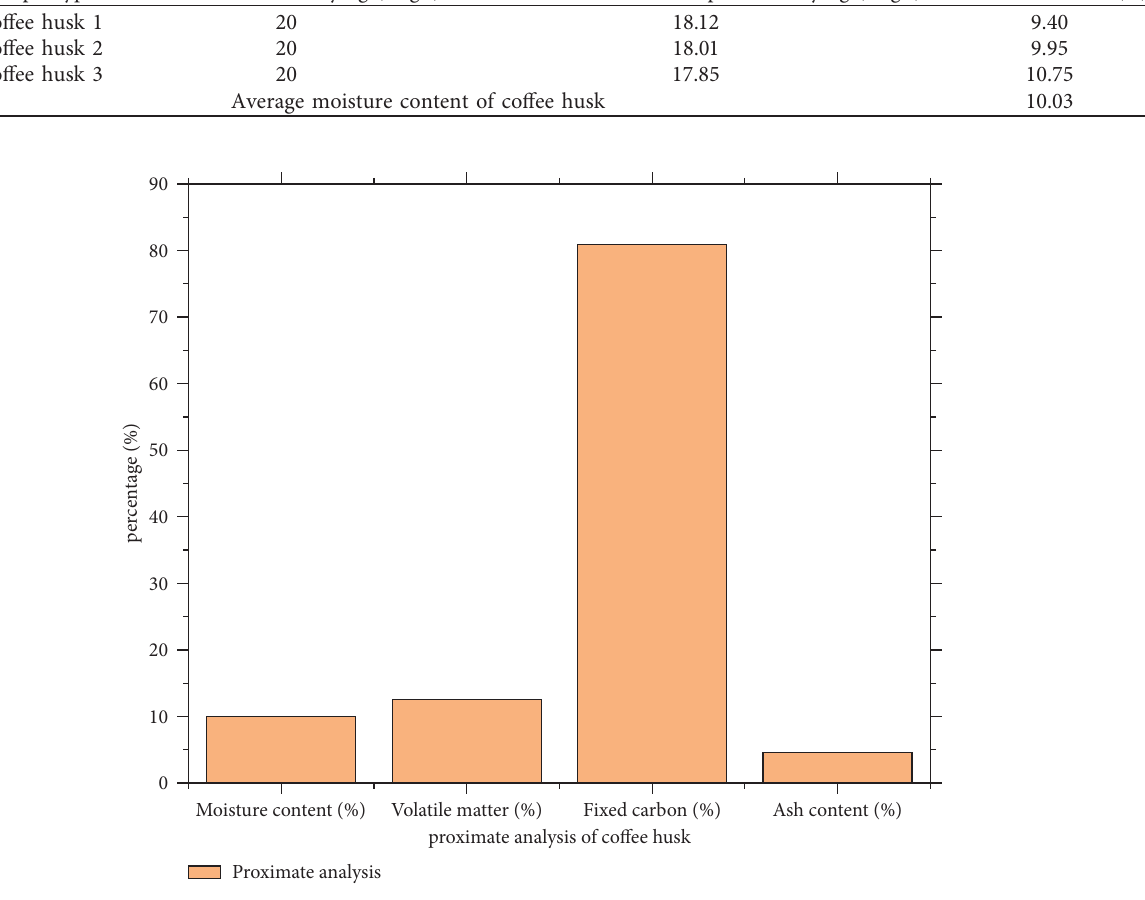
Figure 9: Proximate analysis of coffee husk. Table 3: Effect of temperature on yield and quality of